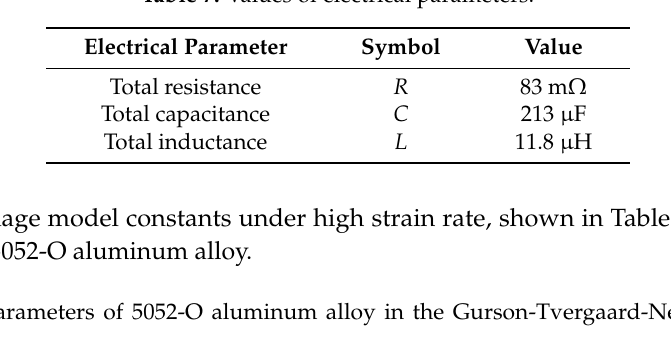
Figure 12. The experiment and fitting curve of 5052-O aluminum alloy. Table 7. Values of electrical parameters.